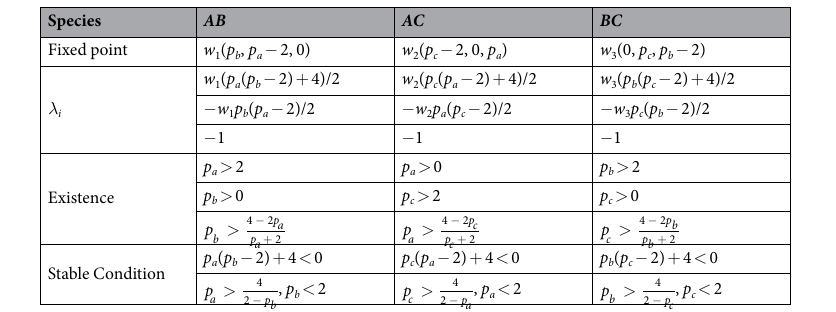
Table 1. Existence and stability conditions of fixed points of type p 2 in the RPS